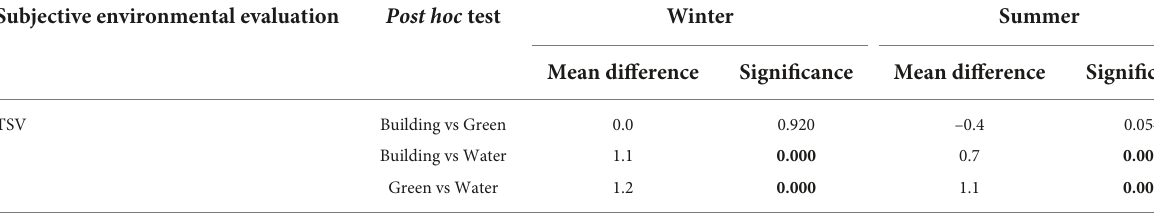
TABLE 5 Post hoc test of the difference in the thermal sensation vote (TSV) values between